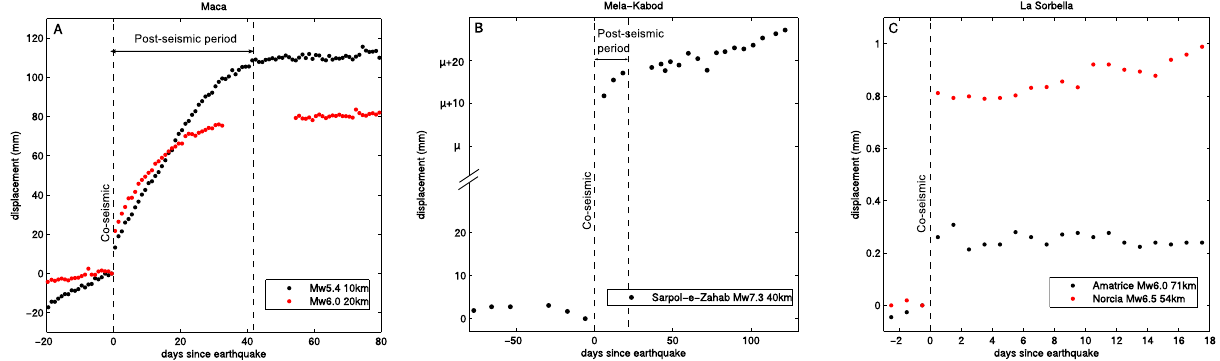
Figure 1. Time-series of slow-moving landslide displacements in the days around several earthquakes. ( A ) GNSS time-series on the Maca landslide (Peru) during 2 local earthquakes (adapted from 5 and 11 ), ( B ) InSAR time-series on the Mela-Kabod landslide (Iran) during a Mw 7.3 earthquake (adapted from 13 , µ represents a co-seismic motion of about 34 m calculated with a satellite image correlation), ( C ) Inclinometer time-series on La Sorbella landslide (Italy) during 2 distant earthquakes (adapted from 10 ). No rainfalls were recorded in